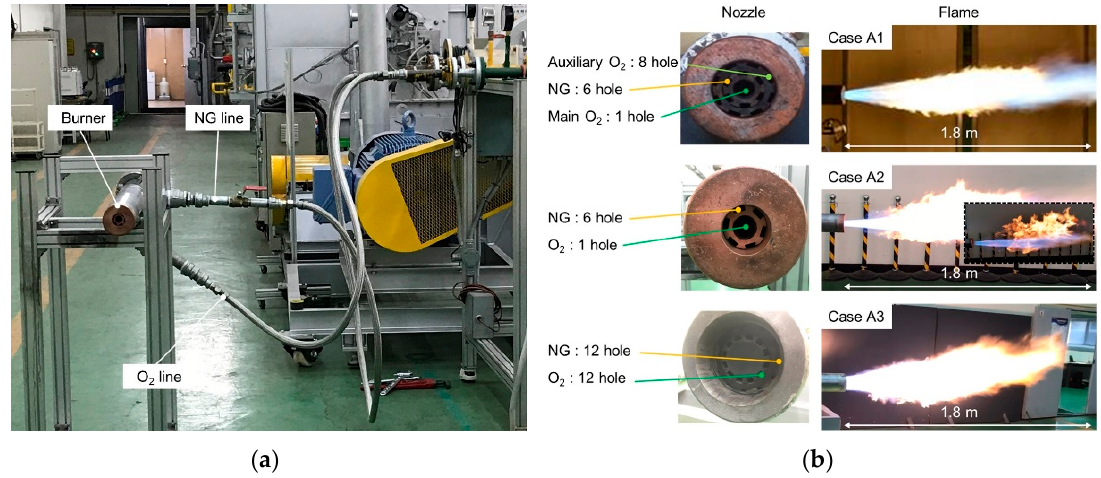
Figure 4. Oxy-fuel burner flame tests: ( a ) photo of flame test rig; ( b ) flame photos with different types of burner nozzle configuration.